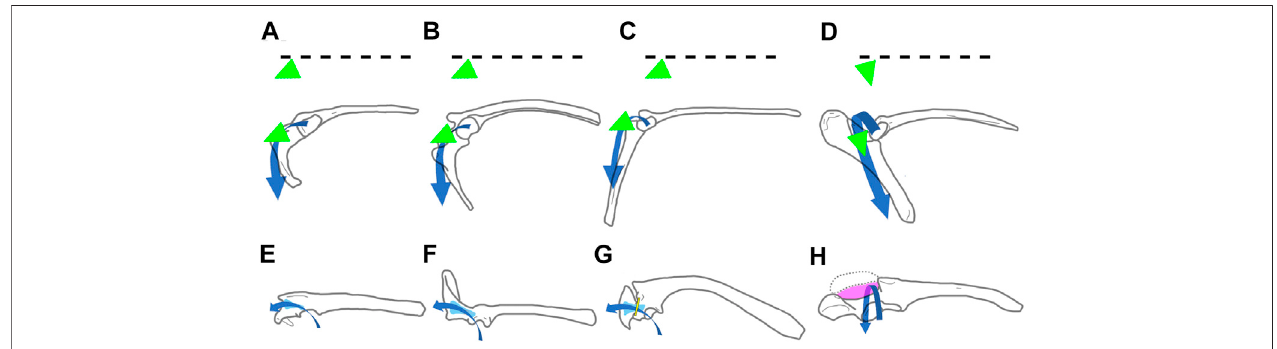
FIGURE 4 | Right scapulocoracoid of selected paravians in lateral (A – D) , and dorsal (E – H) views. (A, E) , Buitreraptor gonzalezorum ; (B, F) , Archaeopteryx lithographica ; (C, G) , Rhea americana ; (D, H) , Vultur gryphus . The broken line indicates the main antero-posterior axis of the scapulacoracoid. Blue, path of the SC; green, fi rst and main action vector of the SC; light blue, supracoracoid canal; yellow, acrocoraco-acromial ligament; violet, triosseal canal. Not to